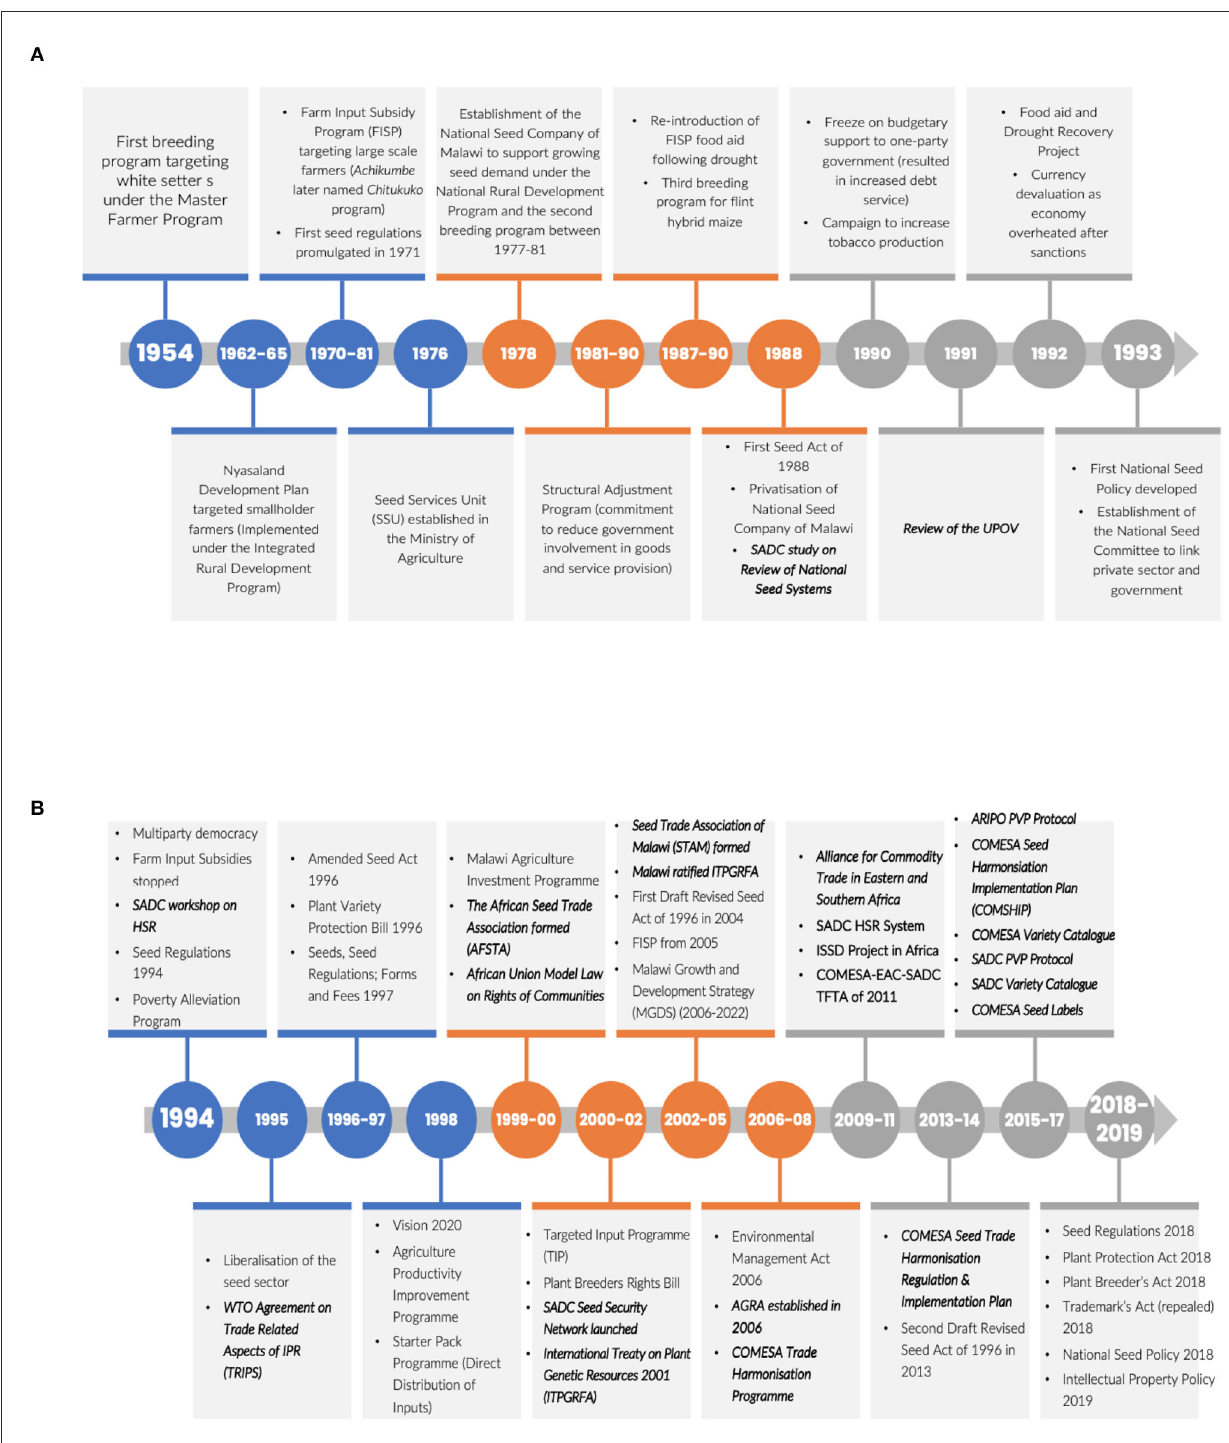
FIGURE2 Key events in the seed sector development in Malawi during (A) after independence (1964–1980), the beginning of structural adjustment (1981–1993), and (B) after the privatization drive of 1995. Note: Boldfaced and italic are regional or global events.